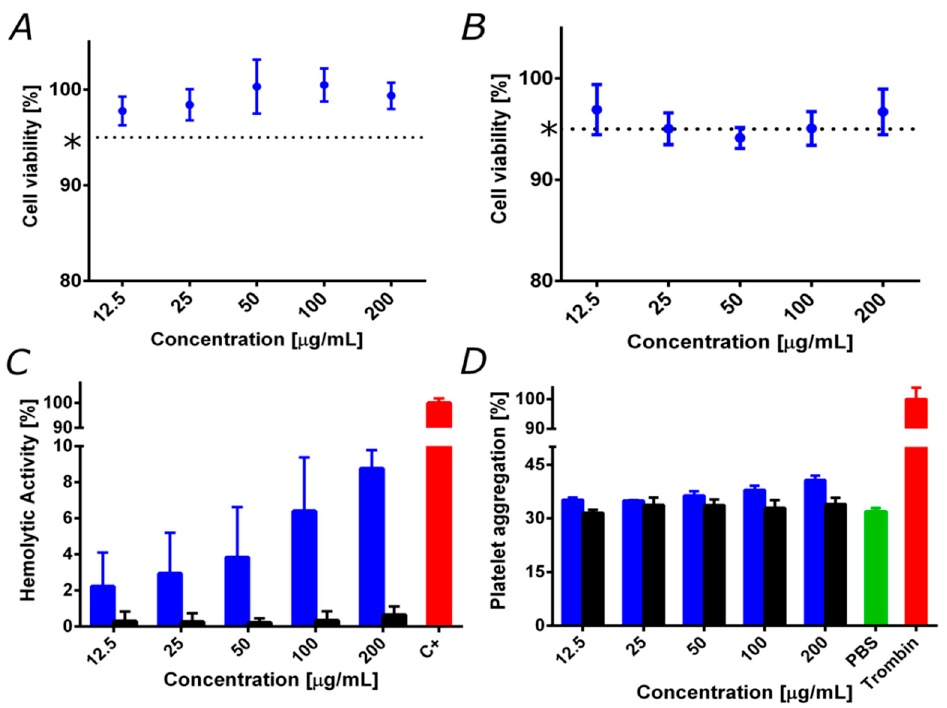
Figure 4. Biocompatibility assays for patchy magnetite / silver (blue) compared to bare magnetite (black). (*) magnetite cell viability reported elsewhere in the same 72 h and further [36,39]. ( A ) Cytotoxicity by lactate dehydrogenase enzyme (LDH) in Vero cells line after 24 h. ( B ) Cytotoxicity by LDH in Vero cells after 48 h. Cell viability remained above 95%. ( C ) The hemolysis assay shows an average hemolytic e ff ect below 10% in all cases. The positive control was Triton 100-X. ( D ) Platelet aggregation assay shows an aggregation tendency of about 40%, which is similar to that of bare magnetite. The negative and positive controls were PBS 1X and thrombin,